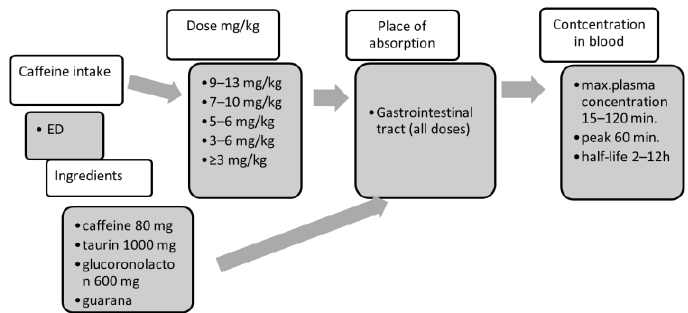
Figure 3. Caffeine absorption.